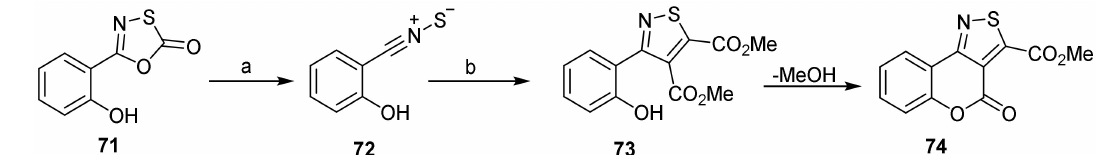
Scheme 21. Synthesis of methyl 4-oxo-4 H -chromeno[4,3- c ]isothiazole-3-carboxylate ( 74 ). Reagents and conditions. ( a ) Heat, -CO 2 , 84% yield; ( b ) EtOAc, DMAD,10 min, 160 ◦ C, microwave, 94% yield. In 2017, Lee and his coworkers reported an efficient intramolecular Rh-catalyzed transannulation of thiadiazoles linked to cyanoalkoxycarbonyl. The ring closure of com- pound 75 was catalyzed by 1,1 (cid:48) -bis(diphenylphosphino) ferrocene DPPF to form the corre- sponding 8-substituted-3-phenyl-4 H -chromeno[4,3- c ]isothiazol-4-ones 76 in good yields of 90–99% (Scheme 22) [52].